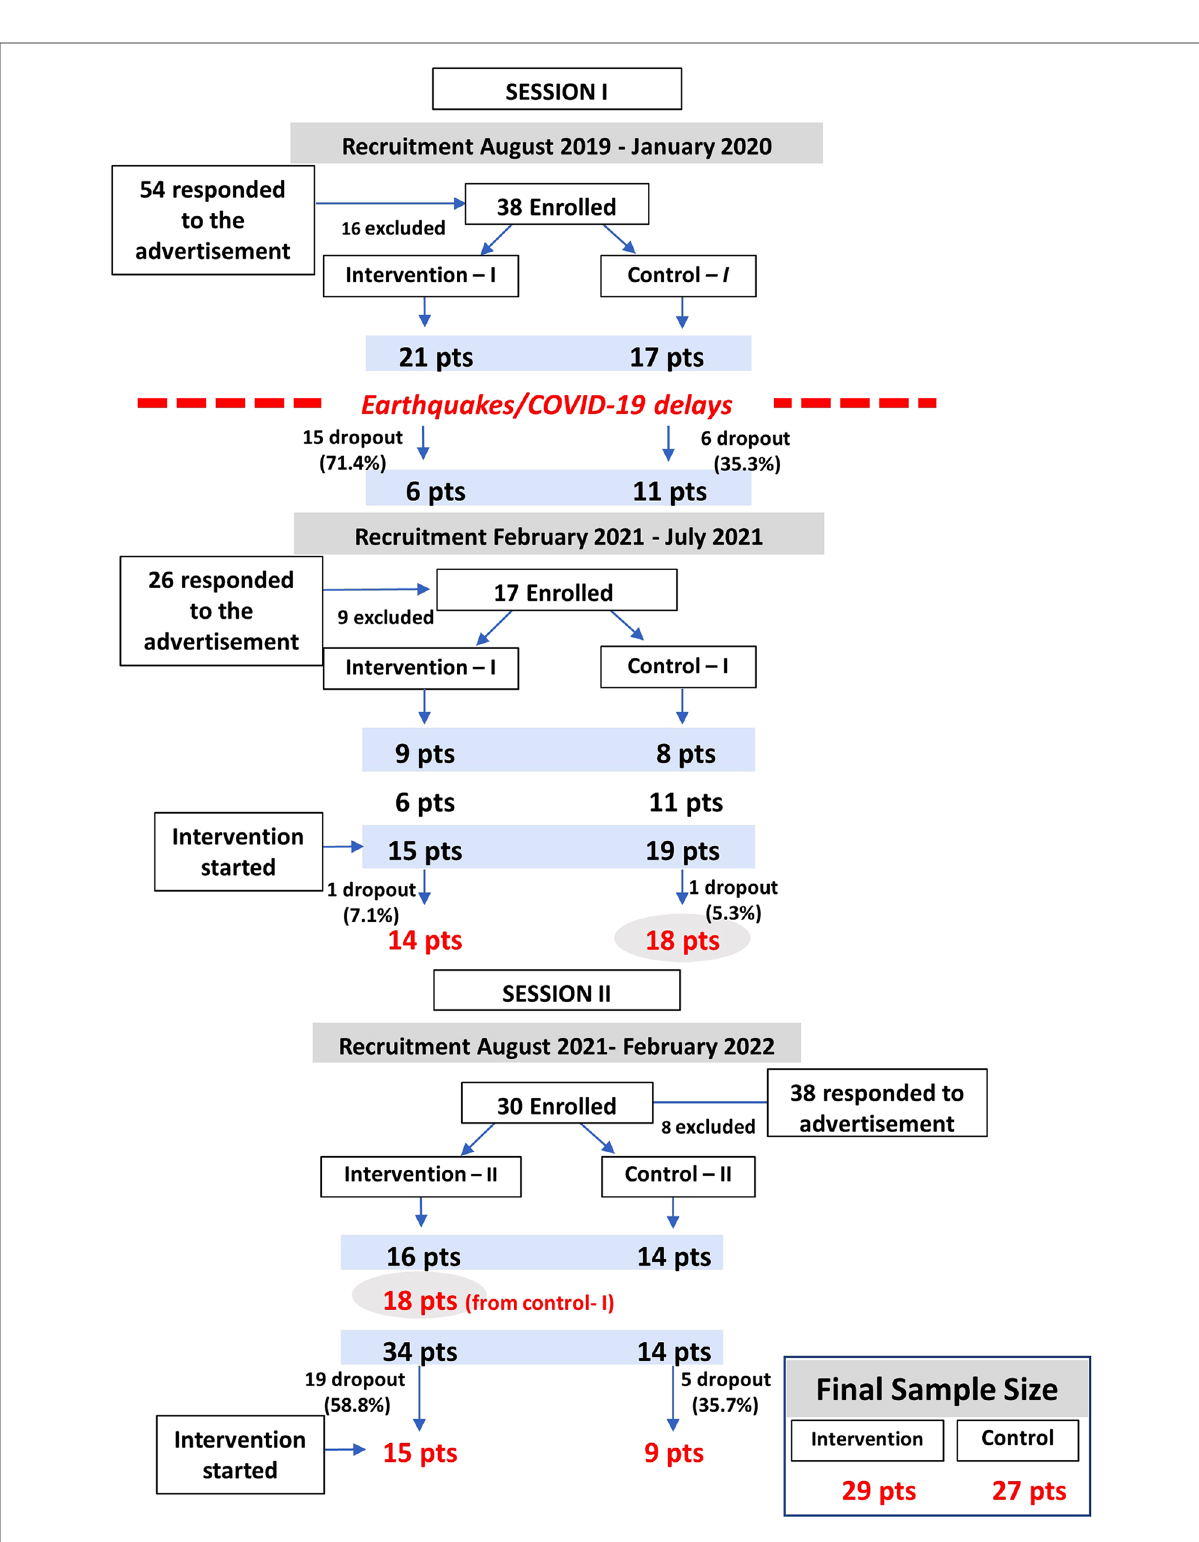
FIGURE 2 Enrollment diagram. The recruitment, enrollment, and retention of the EE pilot RCT are shown. Recruitment was conducted via social media of a patient support foundation. There were two recruitment efforts for Session I which took place from August to October 2021, and one for Session II which took place February to April 2022. A total of 118 individuals were screened and 103 were randomized to the EE vs. control groups. Final enrollment was n =29 (EE) and n =27 (control). Dropout rates were 54.7% for the EE group and 30.8% for the control